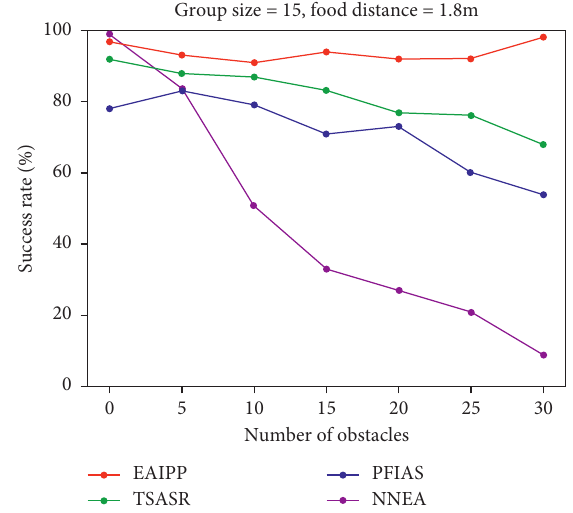
Figure 14: The effect of obstacles on the success rate of the